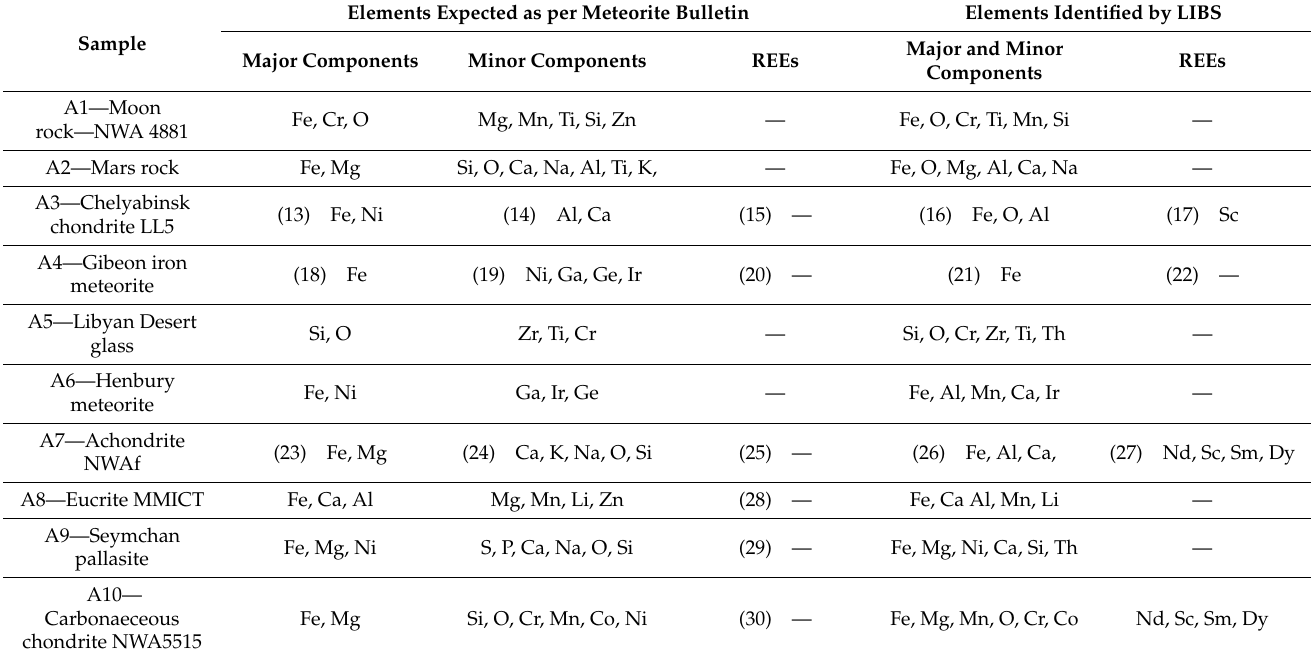
Table 3. Expected and observed elements from meteorite samples using the LIBS